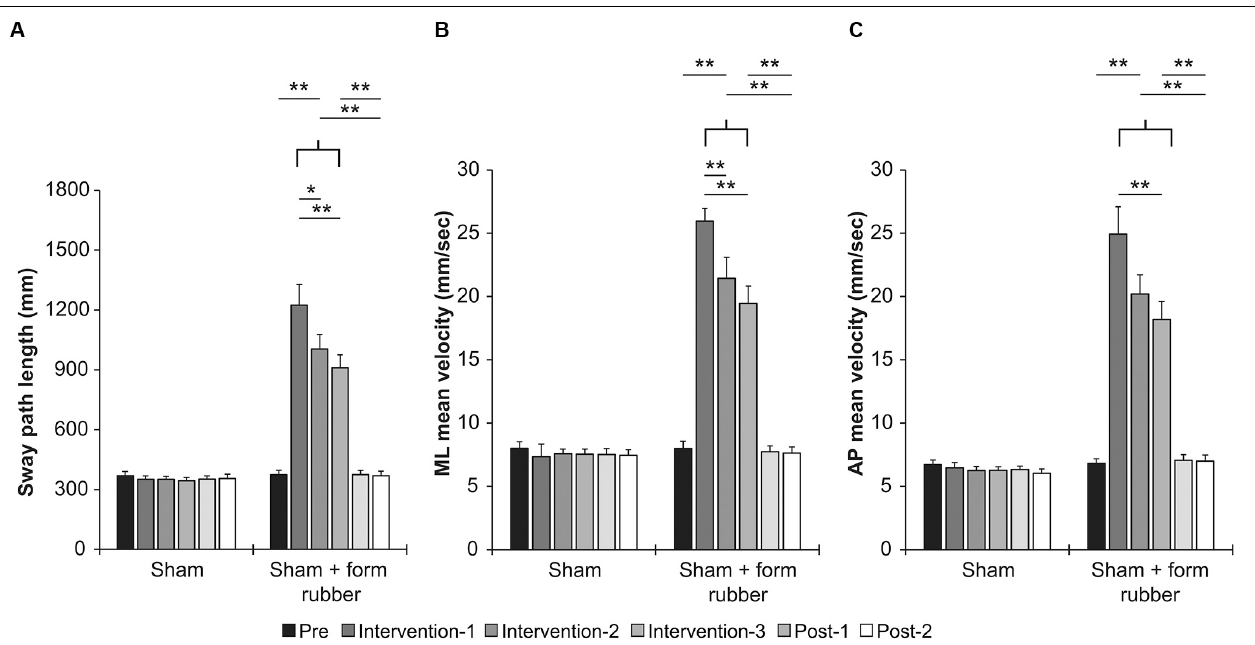
FIGURE 5 | Effects of intervention in the sham condition and sham + foam rubber condition. (A) Sway path length. (B) ML mean velocity. (C) AP mean velocity. Error bars indicate SE.* p < 0.05, ** p <